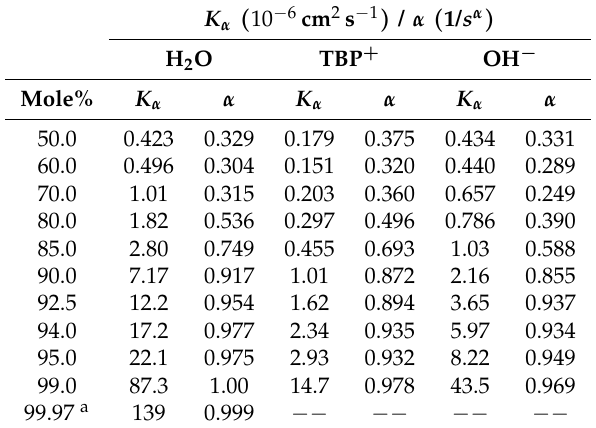
a Infinite-dilution simulation for TBPH. Data for p = 1atm and T =